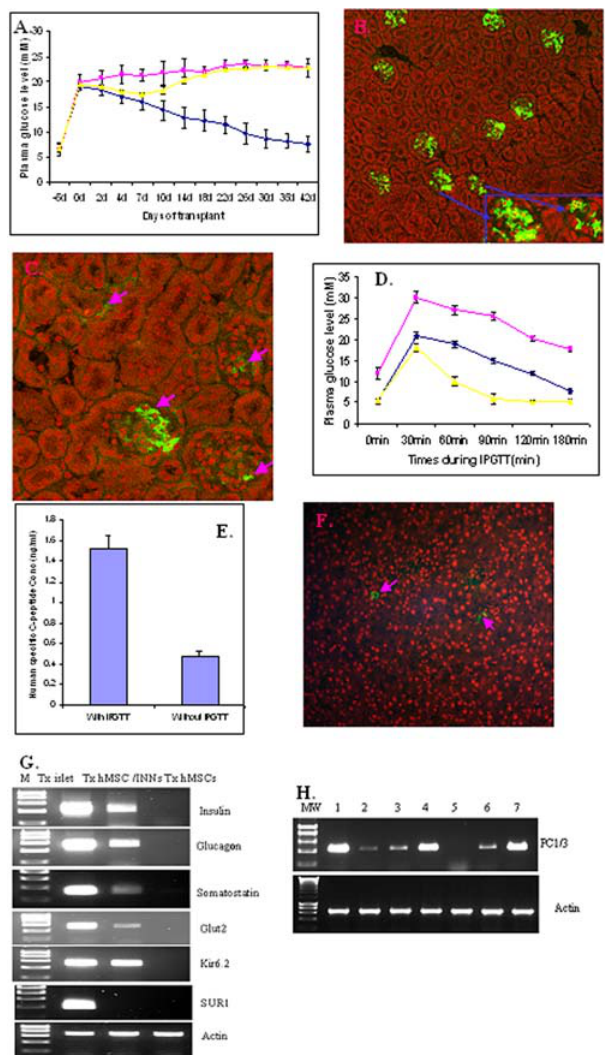
Figure 3. Effect of hMSC/PNNs on plasma glucose in diabetic mice. Panel 3a shows plasma glucose concentrations over days in transplanted mice. The symbol of blue diamond represents mice transplanted with hMSC/PNN (n=16); The yellow triangle represents mice transplanted with hMSC with a phase of differentiation (n=12) and the pink square represent the sham control (n=12). Panel 3b and 3c show the presence of insulin and glucagon positive cells (green fluorescence) in the human MSC/PNNs transplanted grafts in typical mouse kidney sections respectively. In panel 3b, two insulin- expressing clusters were taken at higher power and shown in inset. Panel 3d shows the response of transplanted mice to a glucose challenge. The symbol of blue diamond represents mice transplanted with hMSC/PNN (n=6); The pink square represents mice transplanted with the non-transfected hMSCs with a same phase of differentiation (n=6) and symbol of yellow triangle represents mice transplanted with human islets (800 IEQ/ mouse, n=6). Panel 3e shows the differences in human specific C- peptide in mice after the glucose tolerant test (IPGTT) and without IPGTT. Panel 3f shows the typical residuals of the remaining insulin positive cells (green fluorescence) in the mouse panaceas of hMSC/ PNNs recipients. Please note that the images is presented at low power to give a broad view of the tissue section, emphasizing the disappearing of islet cells from the STZ treated pancreases. Panel 3g shows the presences of mRNA of insulin, glucagons, somatostatin, GluT- 2 and Kir6.2, but lacks of human SUR1 gene, in the kidneys transplanted with hMSC/PNN cells, using mouse kidneys transplanted with human islet cells as positive control, and mouse kidneys transplanted with hMSC cells as negative control. Panel 3h shows the expression